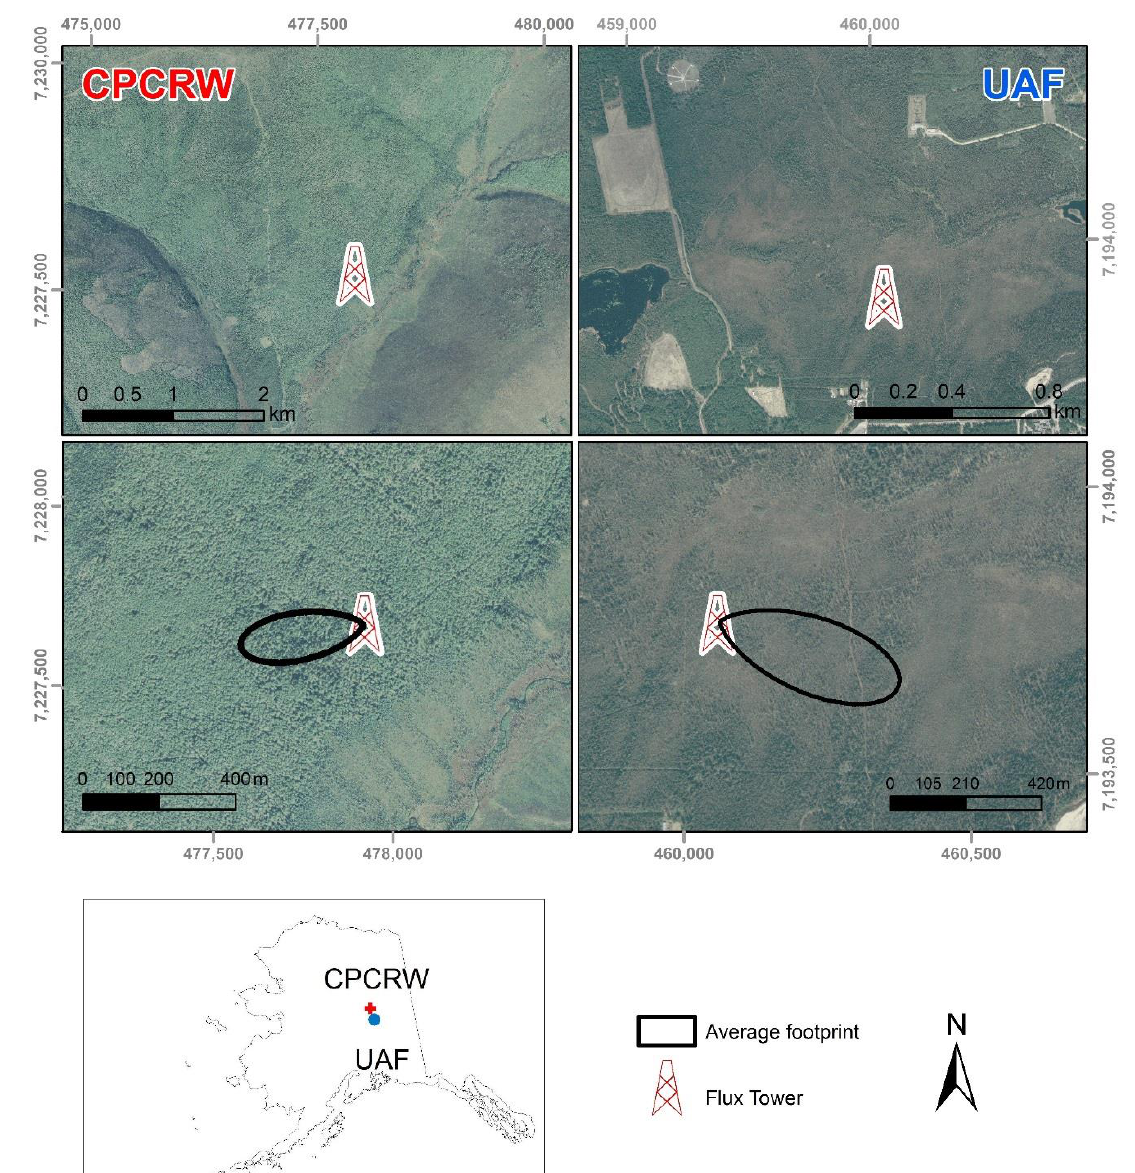
Figure 1. Location of the black spruce (UAF) and the birch (CPCRW) flux towers. Coordinates [km] in UTM-6N Datum NAD-83.